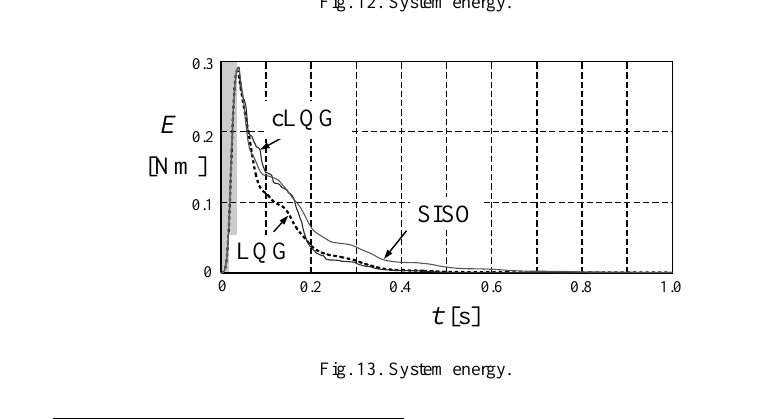
Fig. 12. System energy.